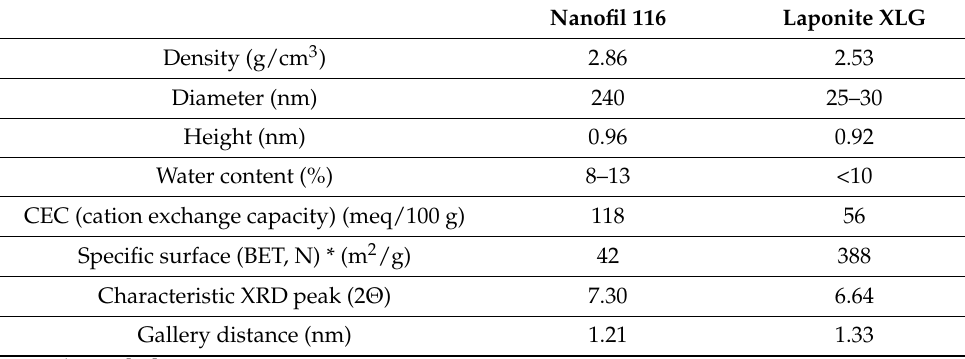
Table 1. Characteristics of Nanofil 116 and Laponite XLG fillers.